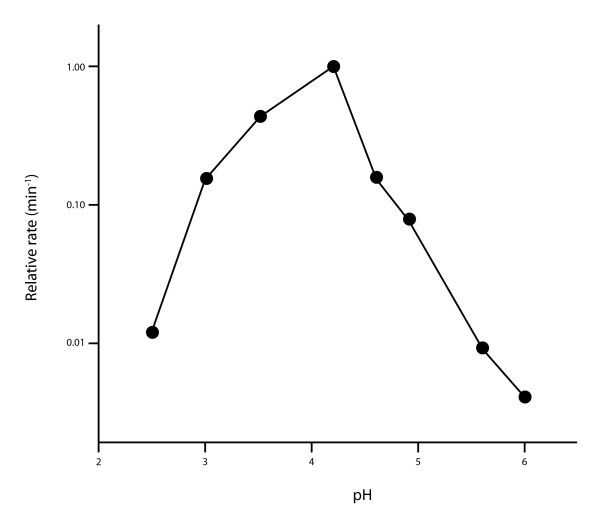
A self-cleaving ribozyme isolated by in vitro-selection has maximal activity at pH 4.2. The rate of cleavage obtained at each pH value was normalized to the maximum rate measured at pH 4.2. Figure adapted with permission from [11] Jayasena and Gold 1997 ©1997 National Academy of Sciences, U.S.A.